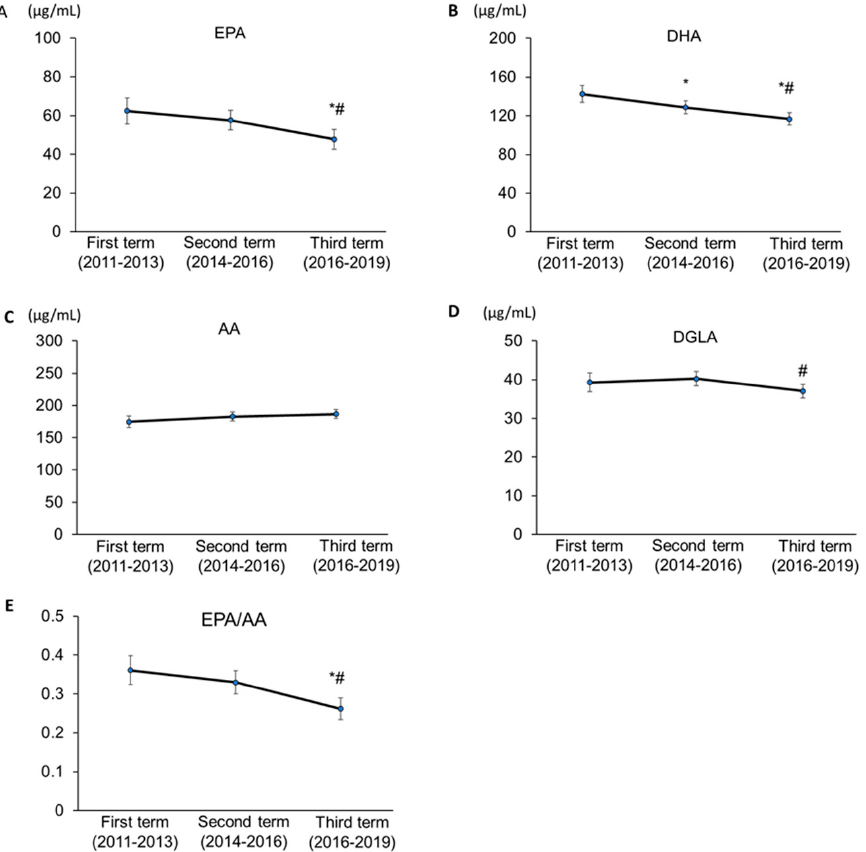
Figure 1. Secular trend in age- and sex- adjusted polyunsaturated fatty acids and EPA/AA. ( A ) EPA, ( B ) DHA, ( C ) AA, ( D ) DGLA, and ( E ) EPA/AA Data are presented as mean ± 95% confidence interval. EPA, eicosapentaenoic acid; DHA, docosahexaenoic acid; DGLA, dihomo- γ -linolenic acid; AA, arachidonic acid. * p < 0.05 versus first term and # p < 0.05 versus second term. Analysis of covariance allowed the comparison of PUFAs among groups while taking into account age and sex. For multiple comparisons, the Bonferroni post-hoc test was applied.